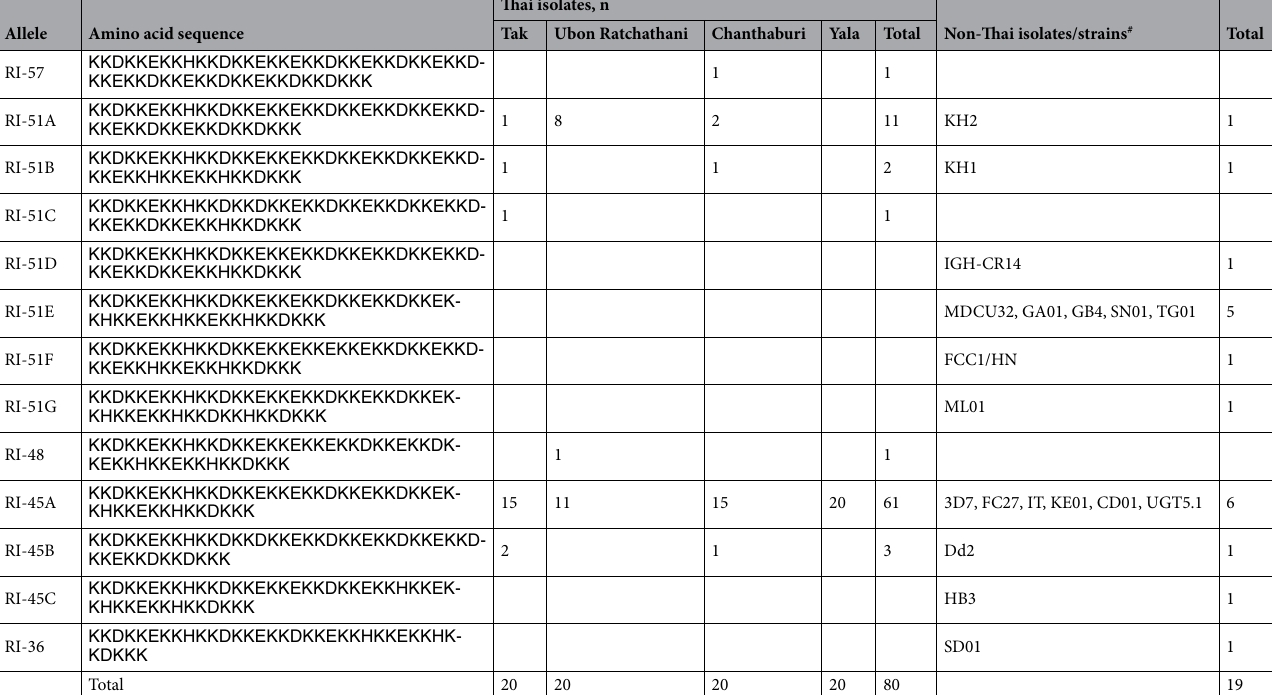
Table 2. Diversity and distribution of repeat alleles in block II (repeat domain I) of PfGARP. MDCU32 is from a Guinean patient. # GenBank accession numbers are listed in “Materials and